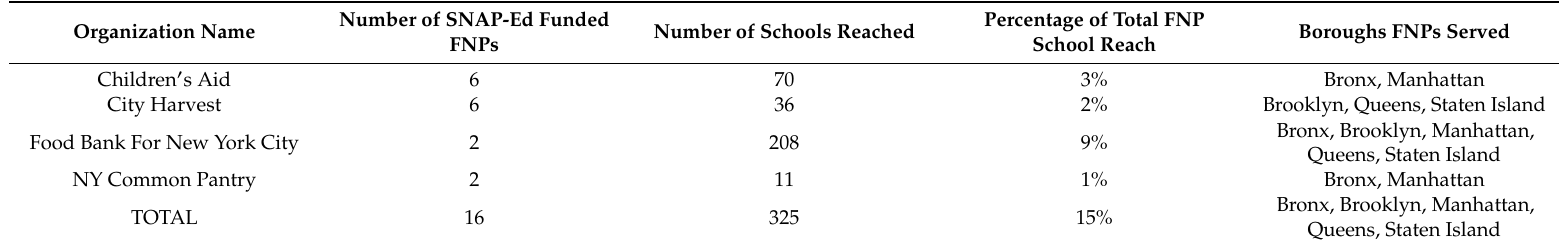
Table 4. SNAP-Ed-Funded Food and Nutrition Education Programs Funded in NYC Schools during the 2016–17 School